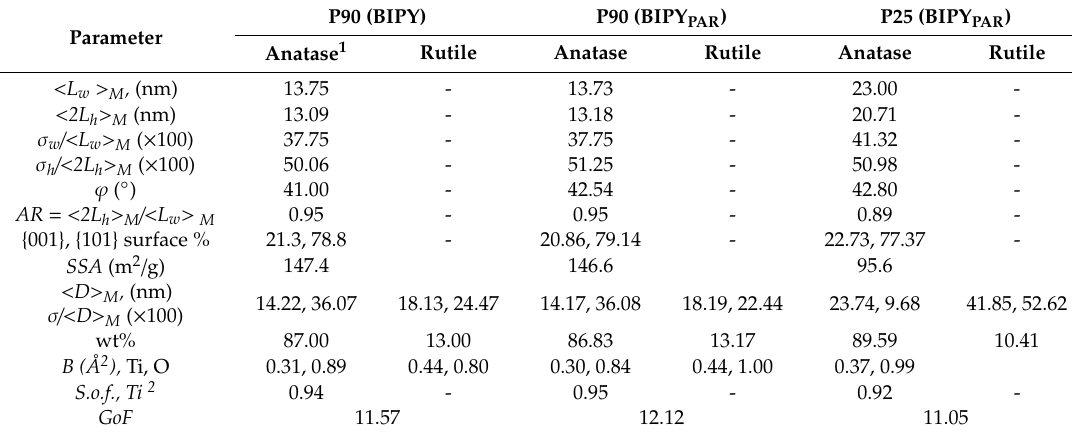
Table 2. Results from the Debye scattering equation (DSE) analysis of P90 and P25 using synchrotron wide-angle X-ray scattering (WAXTS) data and the bipyramids ( BIPY ) and / or prismatic BIPY PAR models for anatase nanocrystals (NCs). Averages are all mass based: equatorial width ( < L w > M ) and length ( < 2L h > M ) of bipyramids, their relative dispersions ( σ w /< L w > M and σ h /< 2L h > M ) and correlation angle ( ϕ ) between growth directions. The aspect ratio ( AR ) is computed from the average width and length of the (pristine or recovered) bipyramids. {101} and {001} surface areas (as % of the total area) are calculated by summing the contribution of all NCs in the population of bipyramids, each NC weighted by its number fraction. The diameter ( < D > M ) and its relative dispersion ( σ /< D > M ) is provided for rutile; for anatase, it refers to the sphere of equivalent volume to that of bipyramids. The number-based averages values are reported in Table A2.